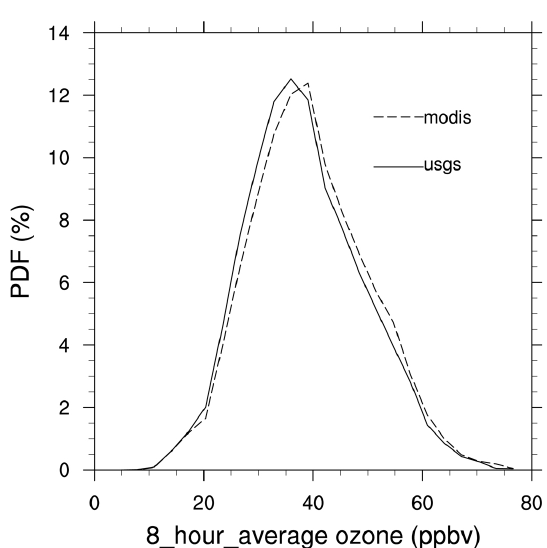
Fig. 9. Probability distributions of surface 8h-average ozone for the E USGS and E